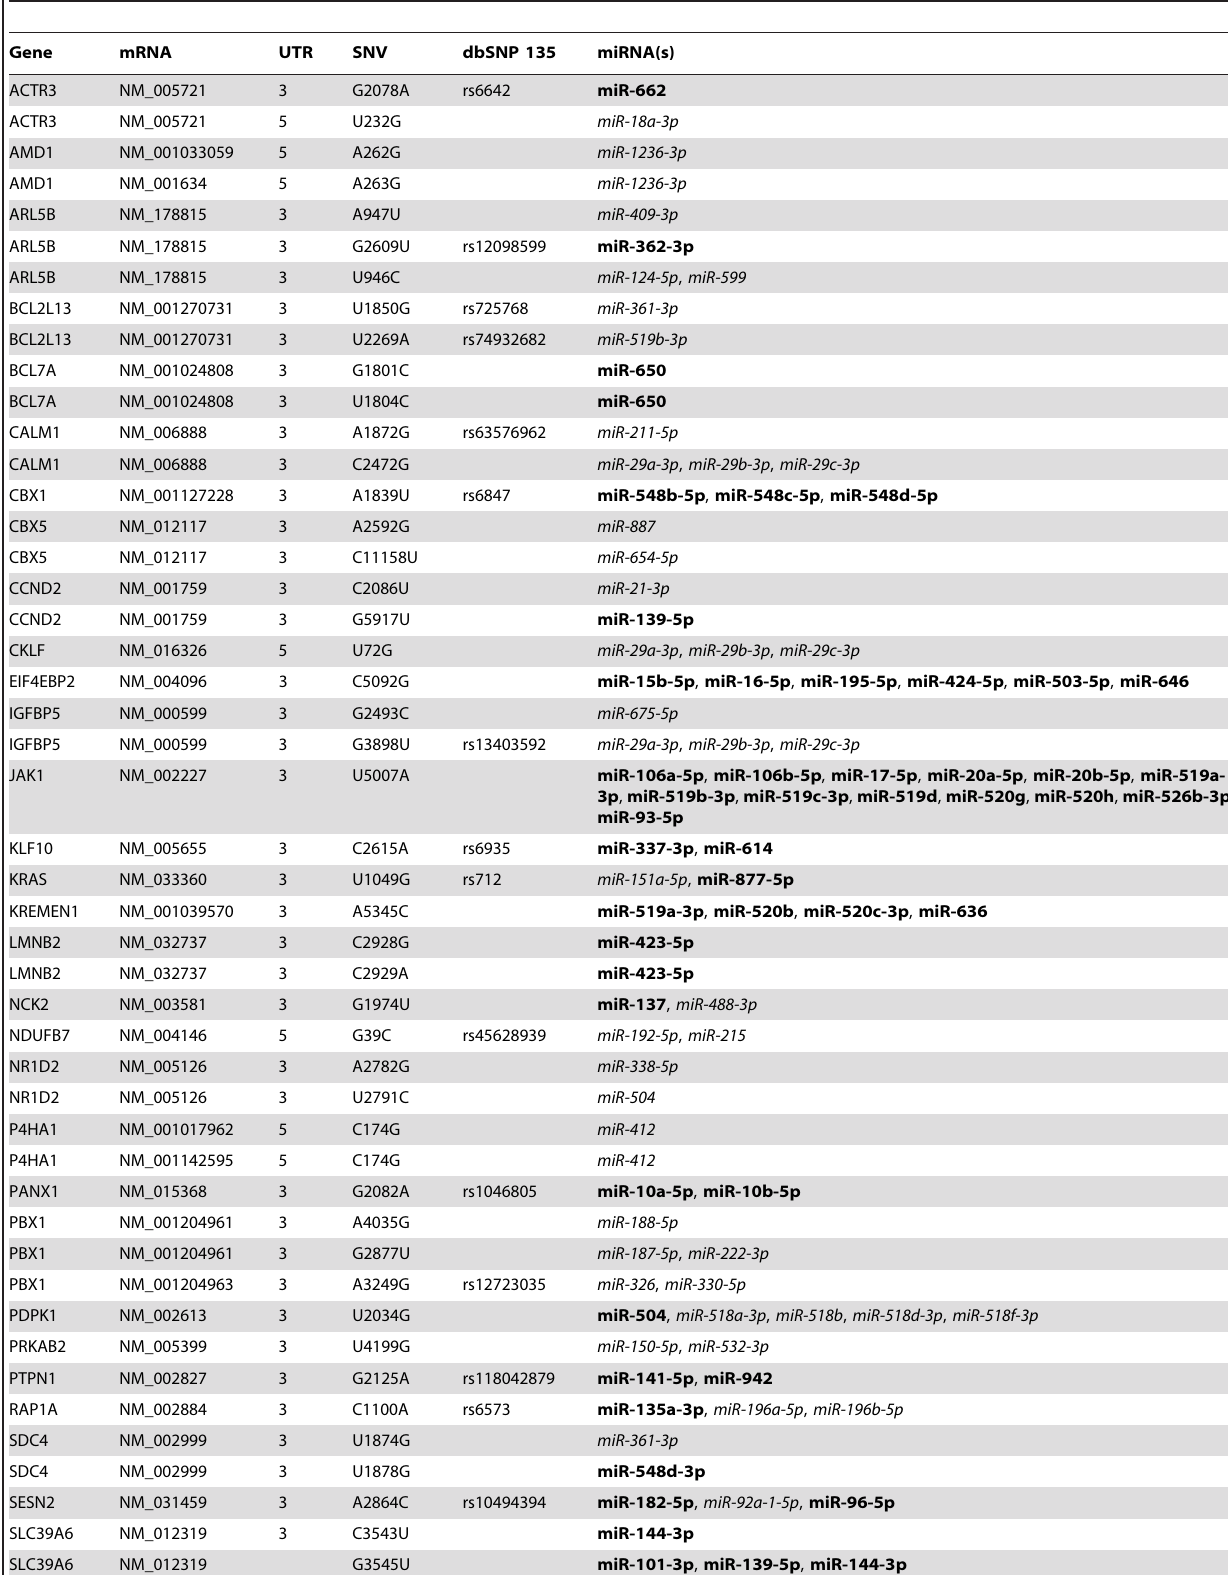
Table 3. List of genes which have more than one miRNA target site change ( create , alter , destroy ) in their UTRs.